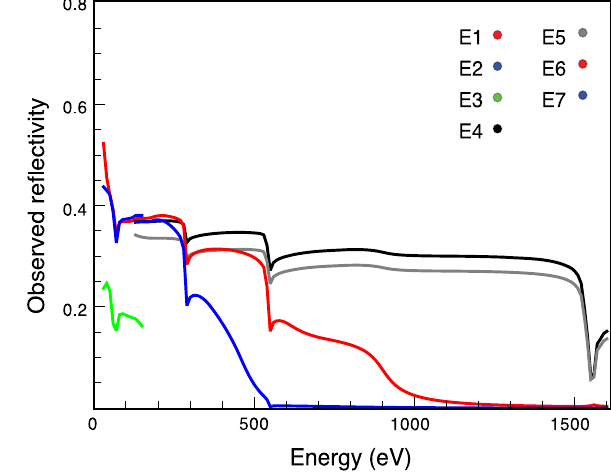
FIG. 34. Calculated reflectivity, as a function of energy, aluminum sample #1, for the cases shown in Fig. (31), but using the scattering model along with grooved surface